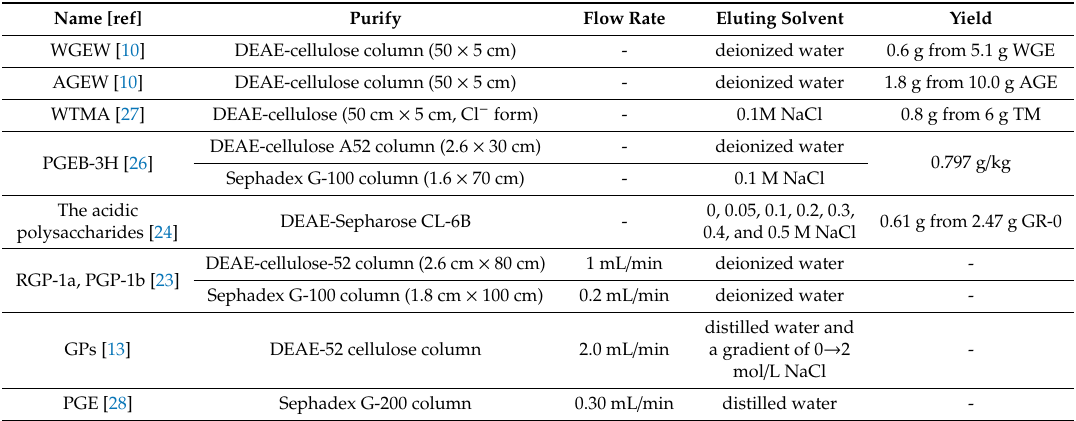
Table 2. The purification methods of several polysaccharides from G. elata